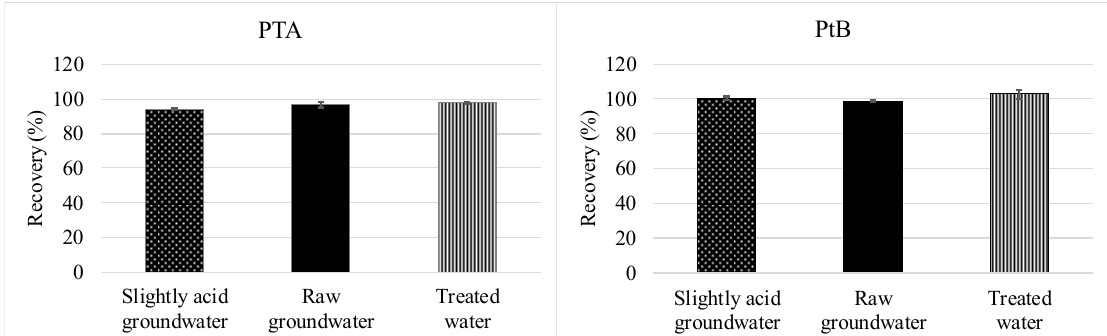
Figure 3. Recovery of PTA and PtB in different spiked groundwater samples handled according to the preservation protocol (48 h between spiking and analysis; 95% confidence limit; n = 6). The error bars represent relative standard deviation (RSD).